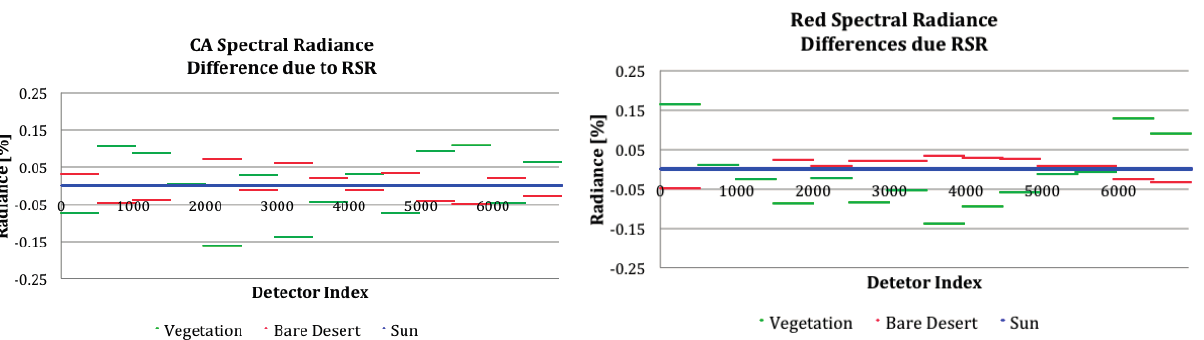
Figure 12. Radiance differences strictly due to the spectral response differences in FPMs for the sample targets, calculated using a band-average RSR, for the CA ( left ) and Red ( right ) bands. There is no difference in the solar data due to differences in the RSR because the solar radiances are used to flat-field the data.